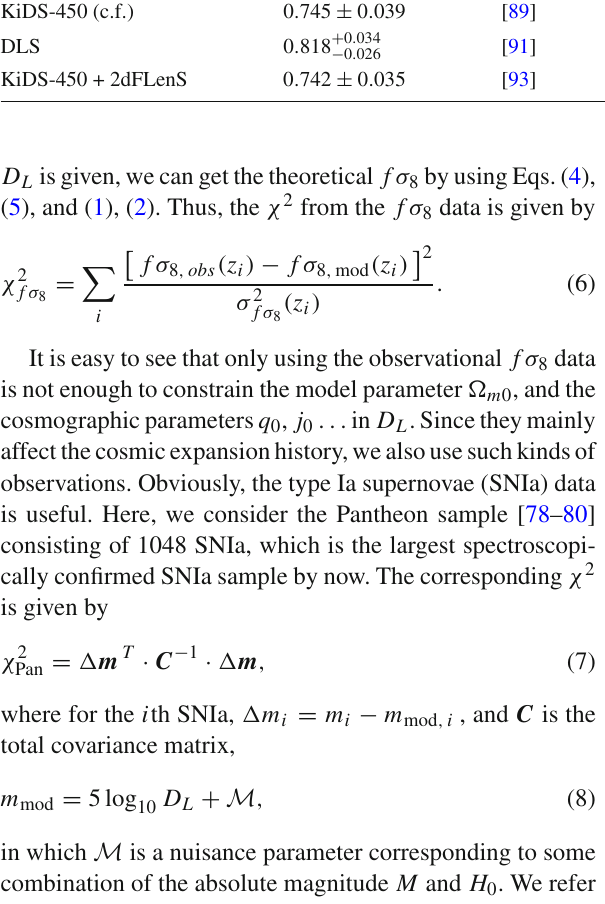
[85] DES (c.s.) 0 . 782 + 0 . 027 − 0 . 033 [87] CFHTLenS 0 . 732 + 0 . 029 − 0 . 020